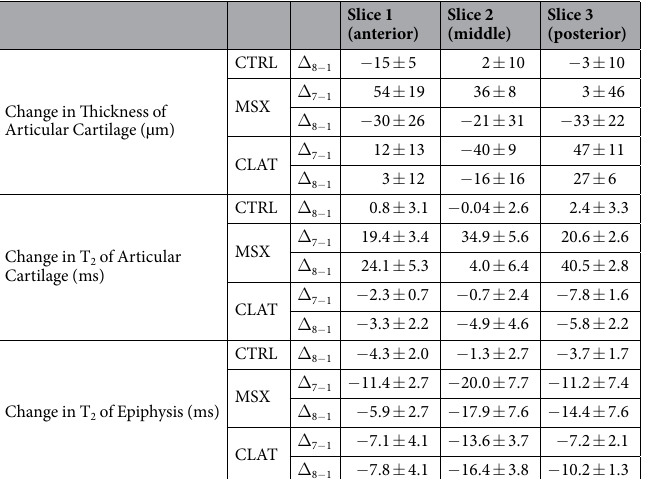
Table 2. The intragroup changes in AC thickness, AC T 2 and T 2 of epiphysis of the medial tibial condyle, for CTRL, MSX and CLAT joints. Δ 7 − 1 is defined as the difference between week 7 and week 1 for the given physical quantity ( A ), the given slice location, and the given group: Δ 7 − 1 = A 7 (group, slice) − A 1 (group, slice). Equivalent definition was used for Δ 8 − 1 : Δ 8 − 1 = A 8 (group, slice) − A 1 (group, slice). The respective quantities were measured from T 2 -weighted MR images and T 2 maps at the three different coronal slice locations shown in Fig. 1. Data is presented as mean ± standard